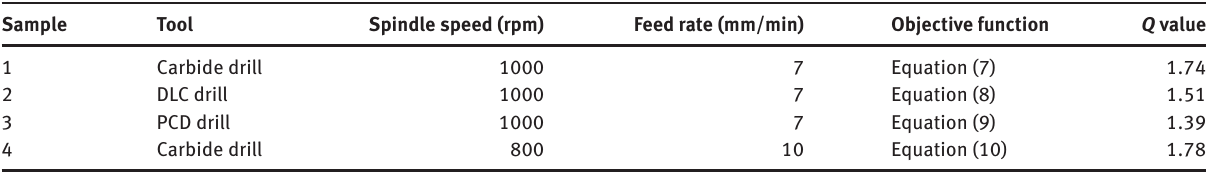
Table 4: Four-group verification schemes.